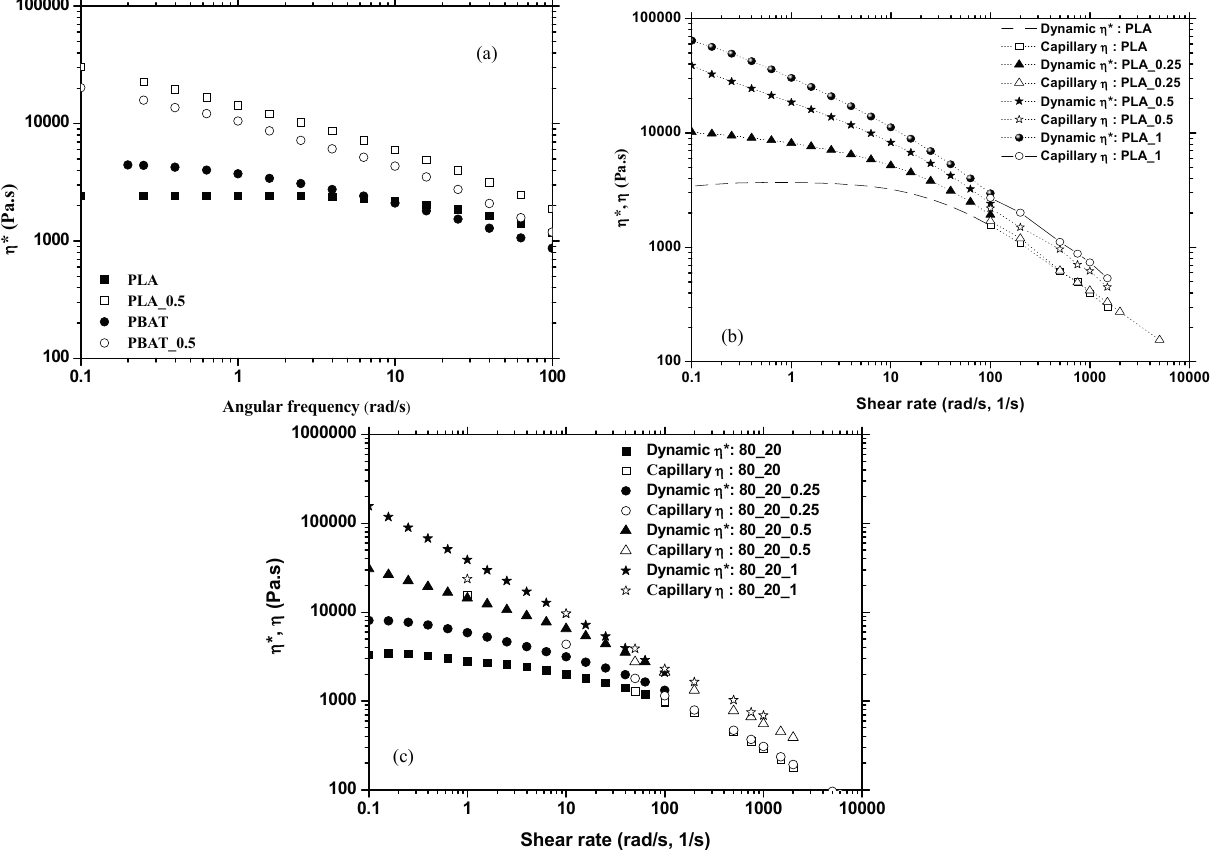
Figure 6. ( a ) Complex viscosity modulus versus angular frequency for neat and modified PLA and PBAT at 180 °C; ( b ) Validity of Cox–Merz rule: Dynamic viscosity modulus and shear viscosity vs. angular frequency (rad/s), shear rate (1/s) for the unmodified and modified PLA, PBAT polymers; ( c ) and for the uncompatibilized and compatibilized PLA–PBAT blends (Full symbol: Dynamic rheology/Open symbol: capillary